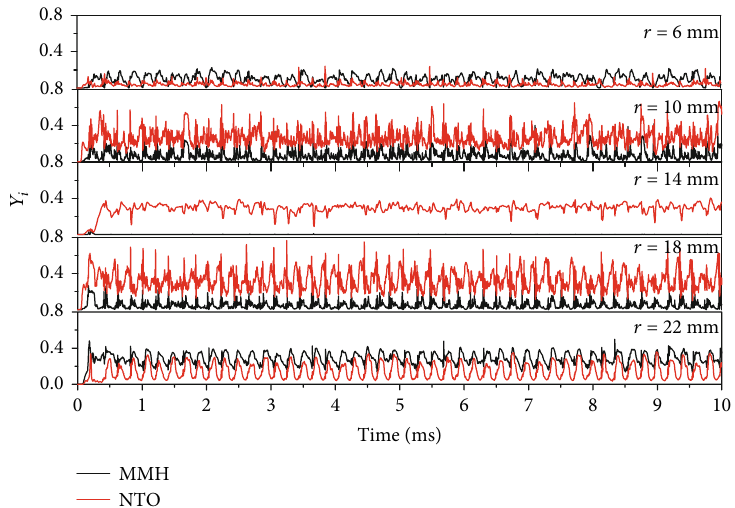
Figure 19: The time histories of mass fraction of MMH and NTO in Case 2.